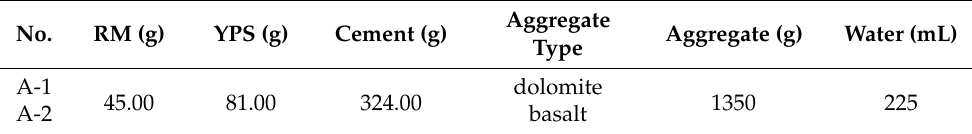
Table 4. The mix design proportions of concrete prepared with RM, YPS, and different aggregates (by weight).